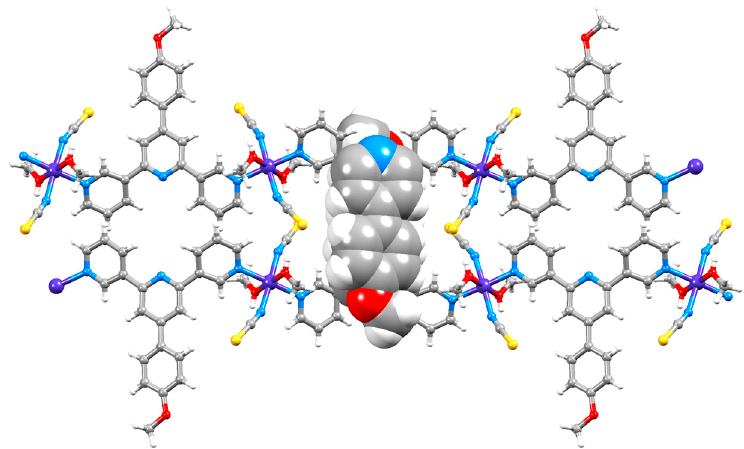
stacked units in Figure 6. The alternate stacking of the purple-coloured chain in Figure 6 with red- and orange-coloured chains leads to extended π -stacking which interlock the chains through the lattice.